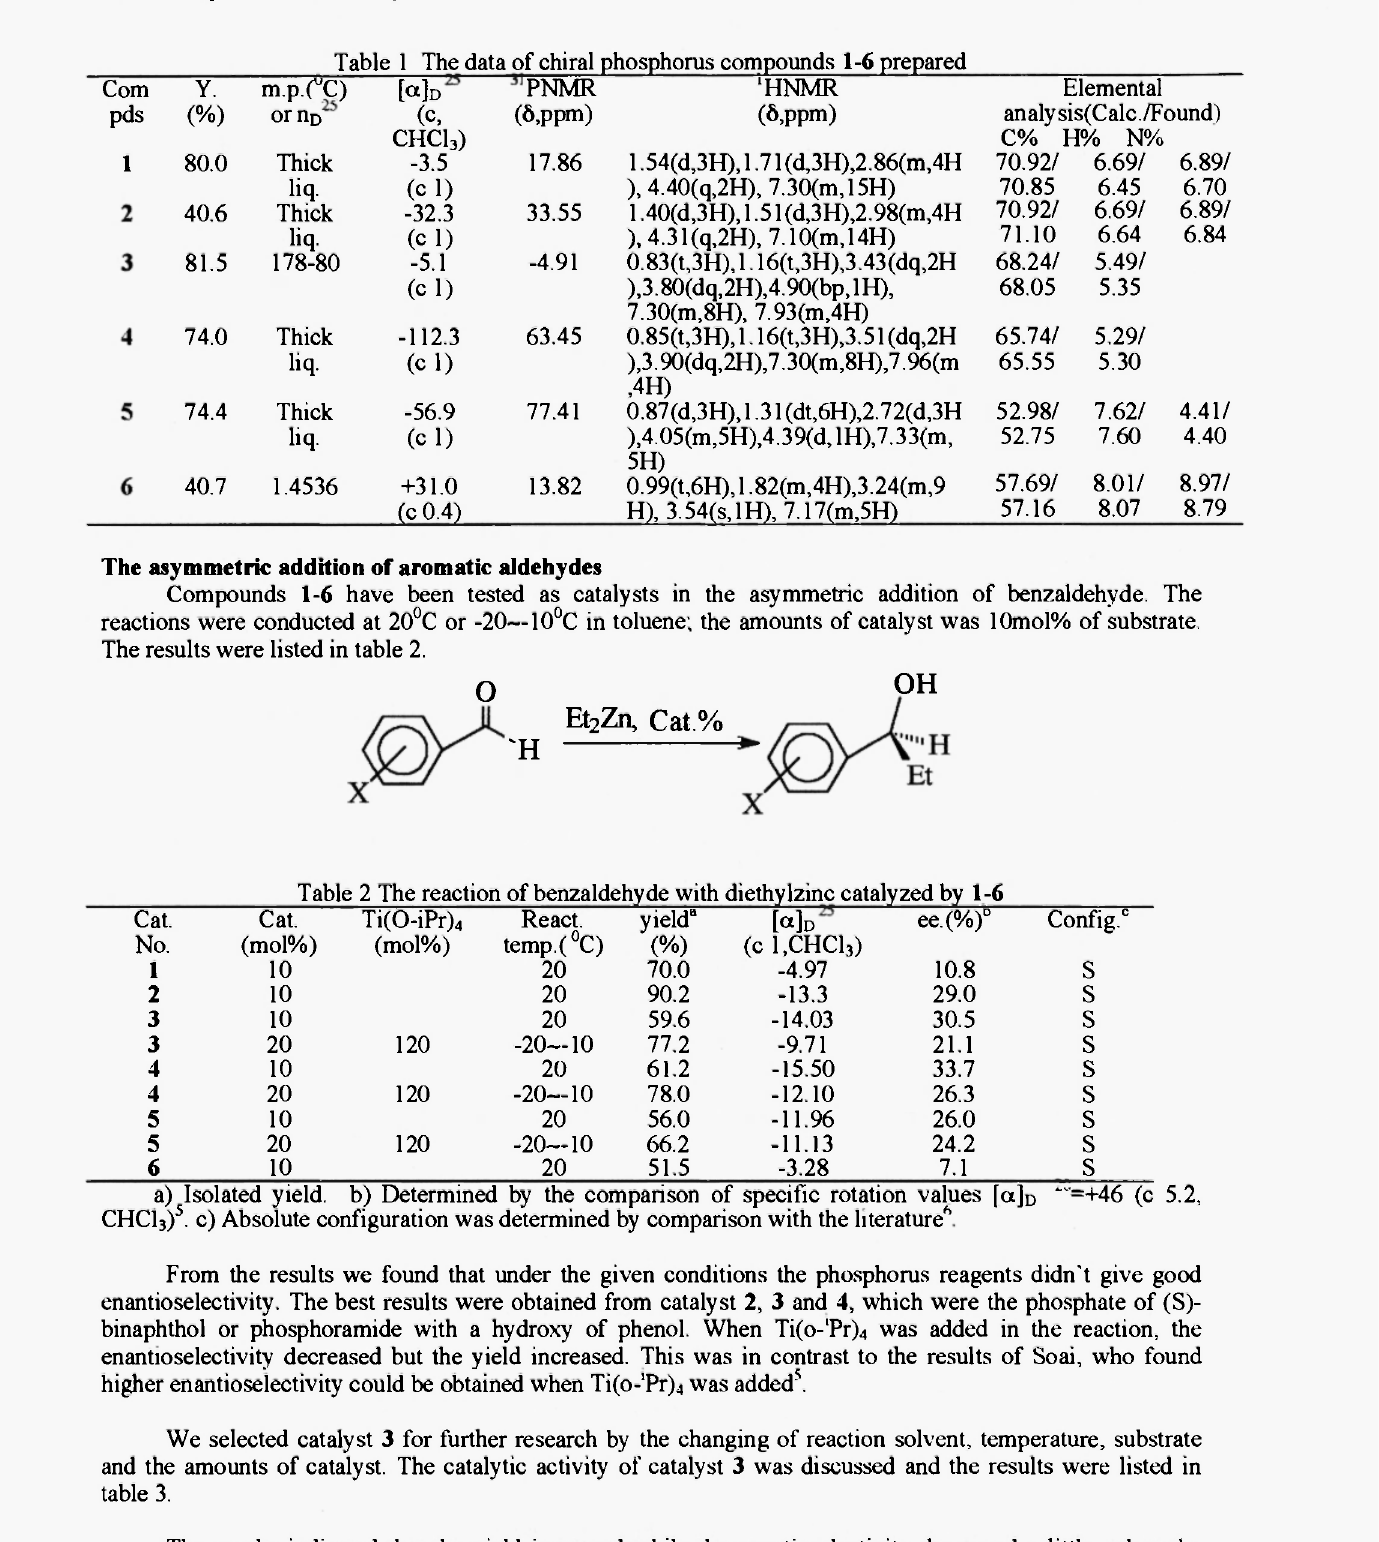
Table 1 The data of chiral phosphorus compounds 1-6 prepared